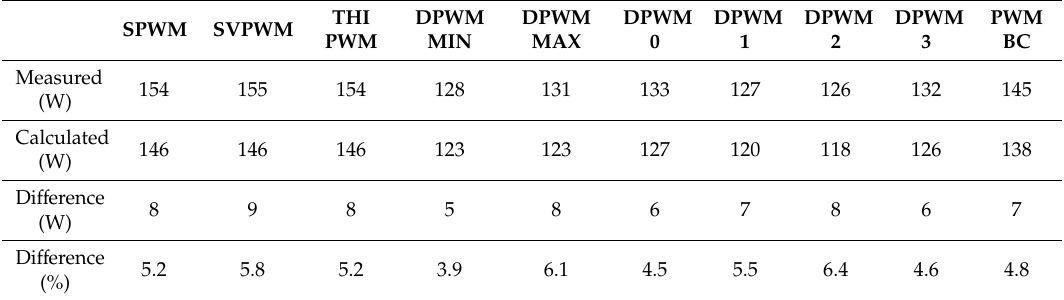
Table 1. Calculated and measured total losses of three-phase inverter at around 12 kVA (for continuous